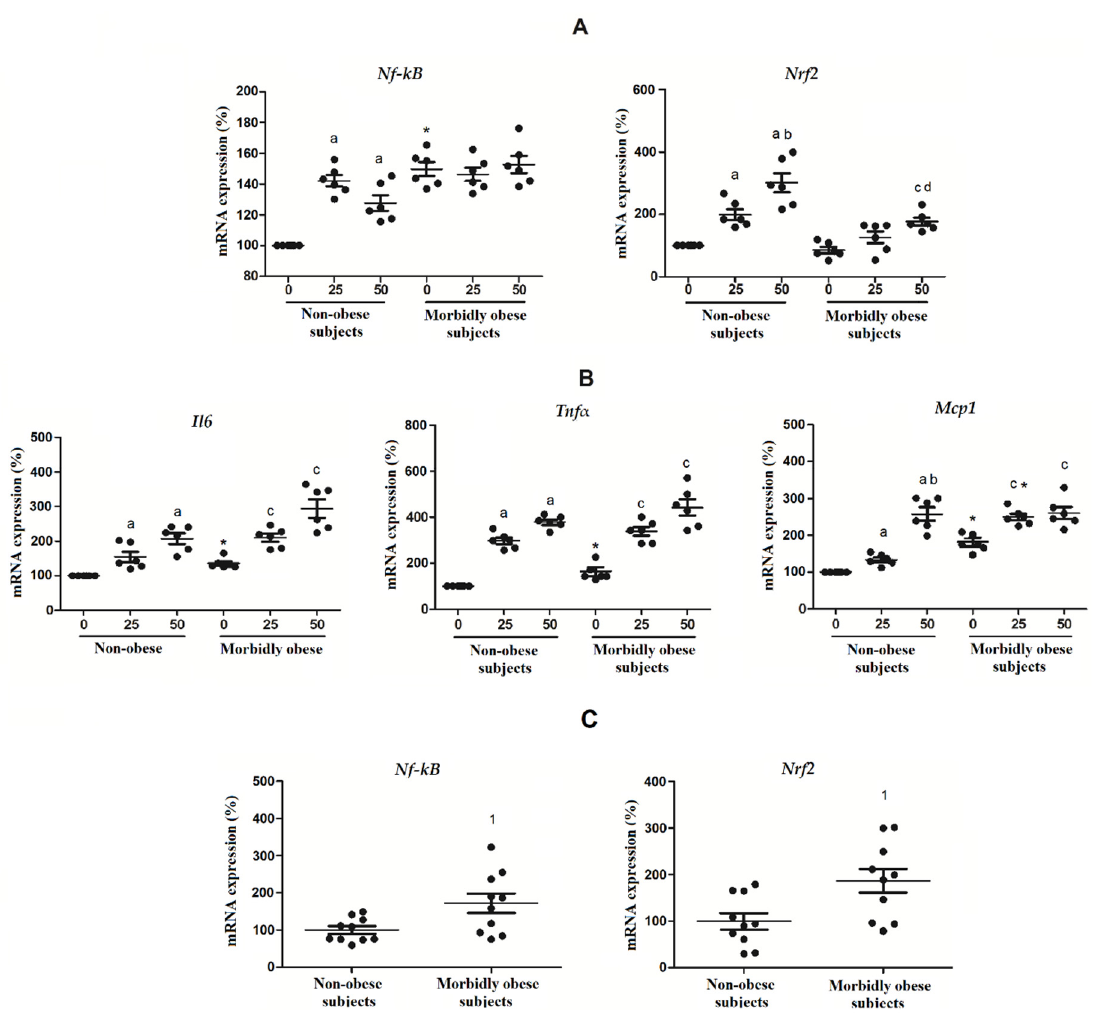
Figure 8. ( A ) Levels of mRNA expression of Nf-kB and Nrf2 and ( B ) NF- κ B-target genes ( Tnf α , Il6 and Mcp1 ) in the in vitro di ff erentiated adipocytes obtained from HMSC from non-obese ( n = 6) and morbidly obese subjects ( n = 6) incubated with 0, 25 and 50 µ g / mL of oxLDL for 24h. a p < 0.05: significant di ff erences with regard to 0 µ g / mL oxLDL within non-obese subjects. b p < 0.05: significant di ff erences with regard to 25 µ g / mL oxLDL within non-obese subjects. c p < 0.05: significant di ff erences with regard to 0 µ g / mL oxLDL within morbidly obese subjects. d p < 0.05: significant di ff erences with regard to 25 µ g / mL oxLDL within morbidly obese subjects. * p < 0.05: significant di ff erences for each dose between non-obese and morbidly obese subjects; ( C ) levels of mRNA expression of Nf-kB and Nrf2 in visceral mature adipocytes obtained from visceral adipose tissue of non-obese ( n = 10) and morbidly obese subjects ( n = 10). 1 p < 0.05: significant di ff erences with regard to non-obese subjects.